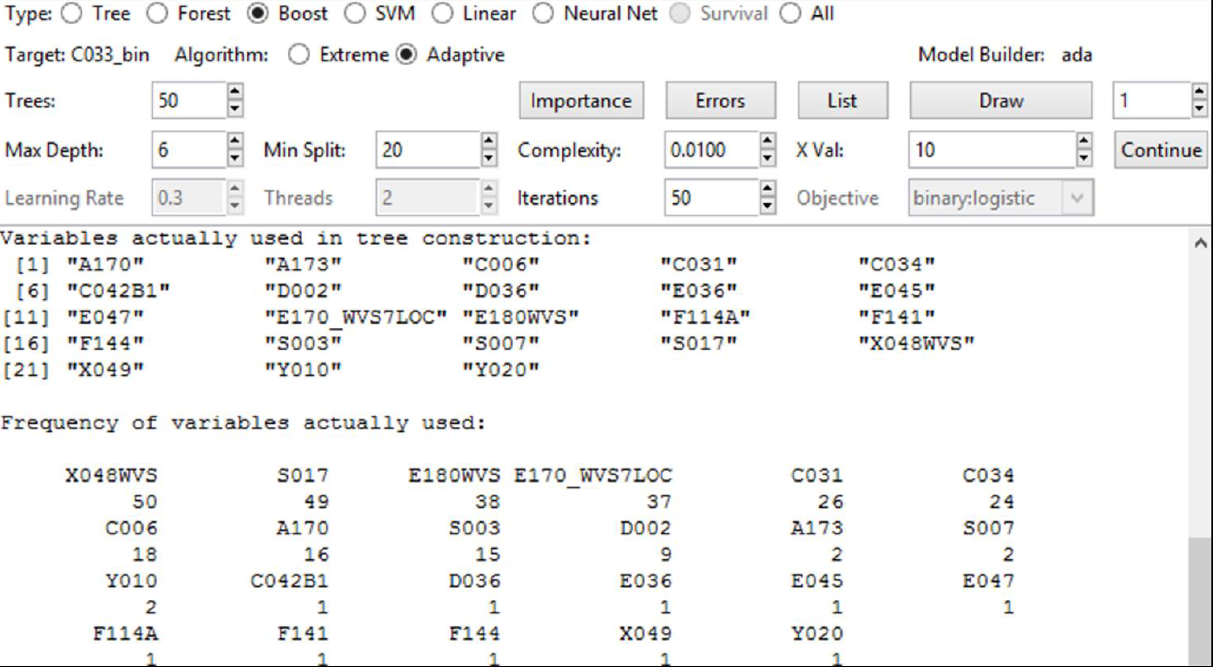
Figure 4. Alternative results as obtained using the Adaptive Boosting technique in the Rattle library of R.